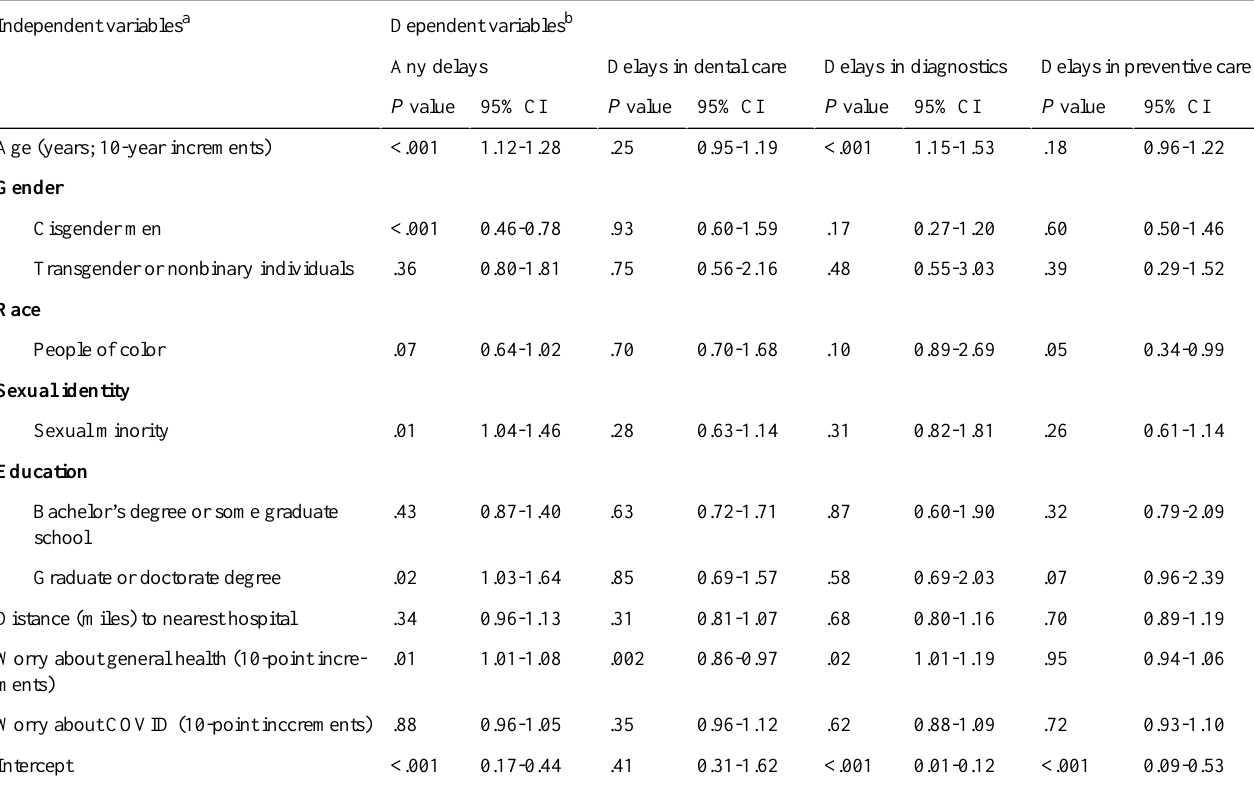
Table 5. Multiple logistic regression of reasons for experiencing health care delays resulting from the COVID-19 pandemic.